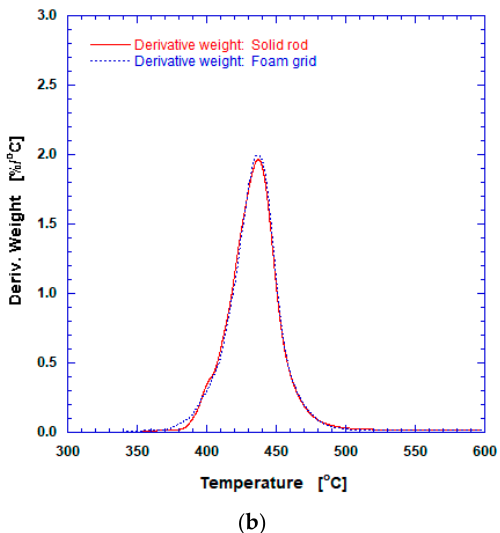
Figure 4. ( a ) DSC and ( b ) TGA thermograms of the samples for solid rod and foam grid .